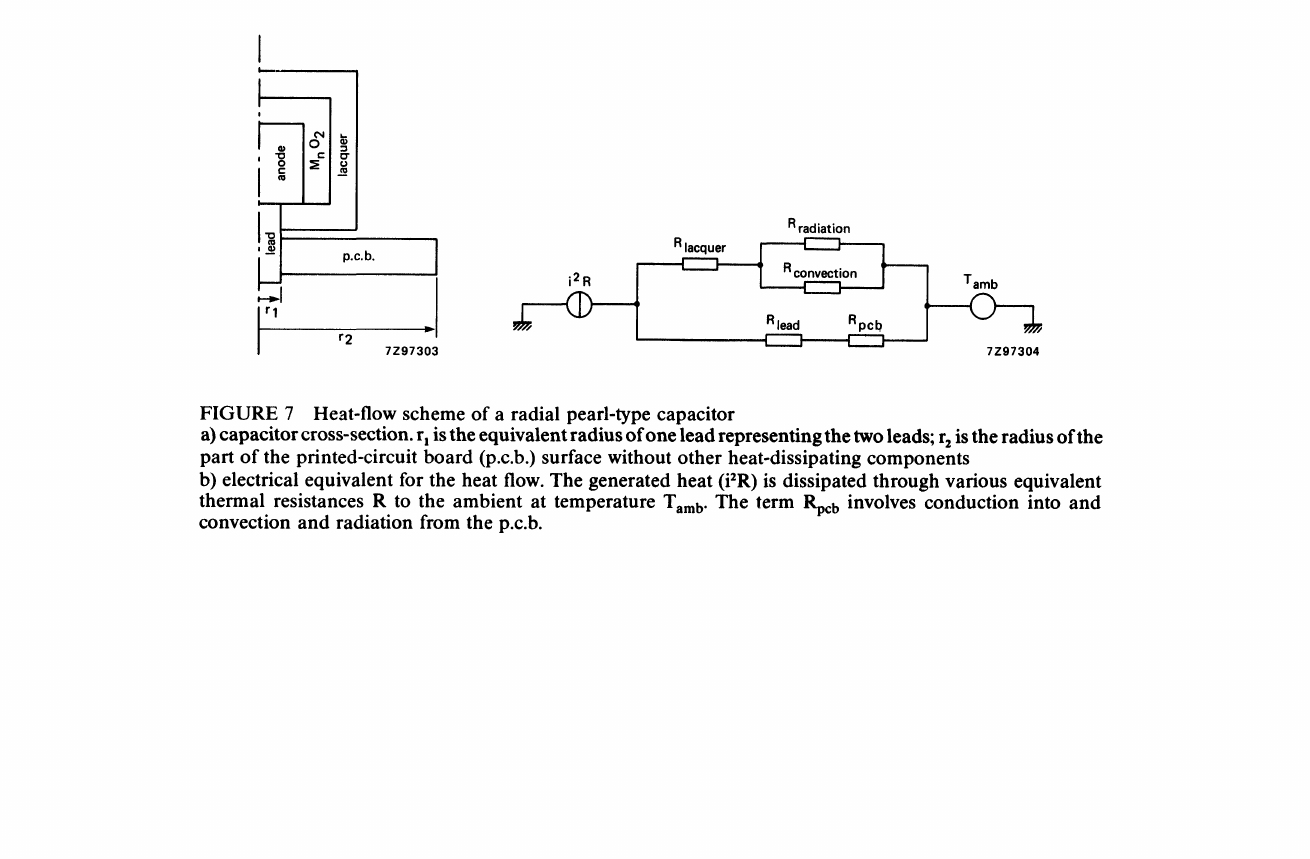
FIGURE 7 Heat-flow scheme of a radial pearl-type capacitor a) capacitor cross-section, r is the equivalent radius of one lead representing the two leads; r is the radius of the part of the printed-circuit board (p.c.b.) surface without other heat-dissipating components b) electrical equivalent for the heat flow. The generated heat (iR) is dissipated through various equivalent thermal resistances R to the ambient at temperature Tam convection and radiation from the